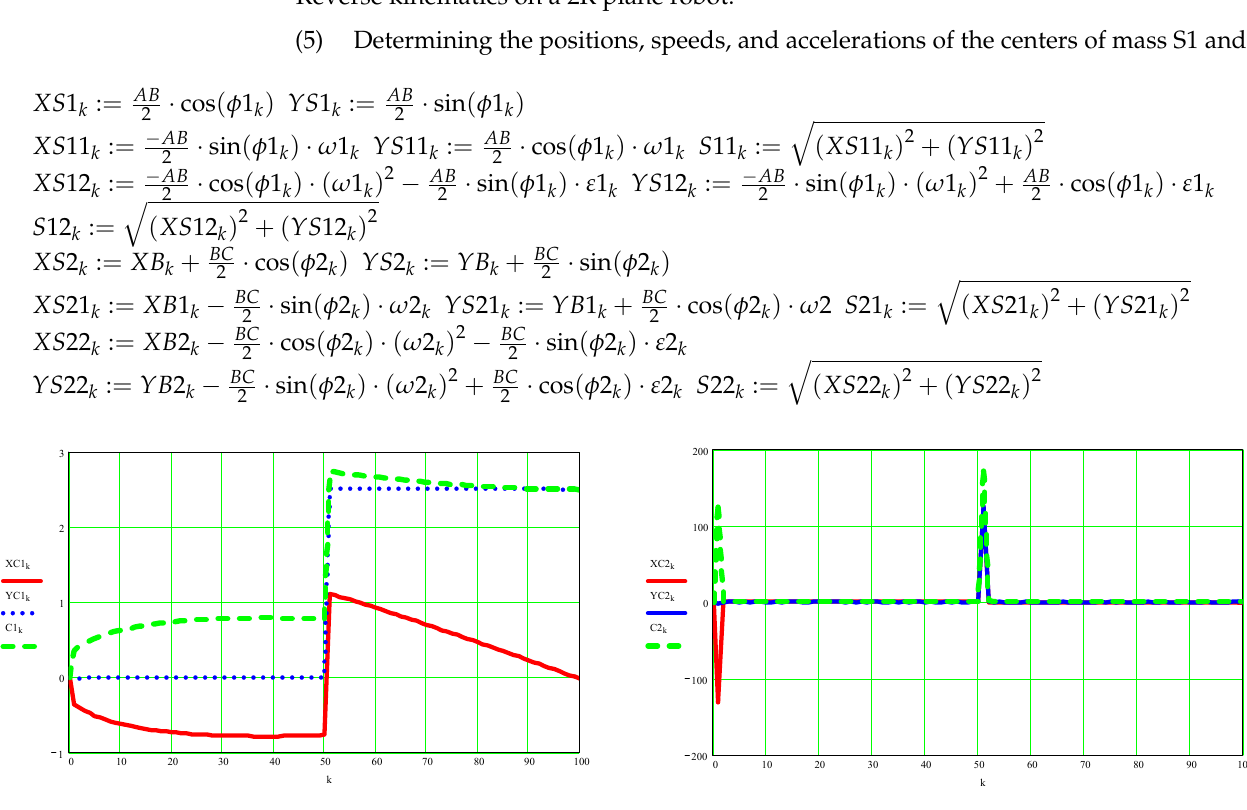
Figure A7. On the left side are the scalar coordinates of the speed of point C (red and blue) and its absolute speed (green); on the right the graphs of the accelerations of the same point C. Reverse kinematics on a 2R plane robot.